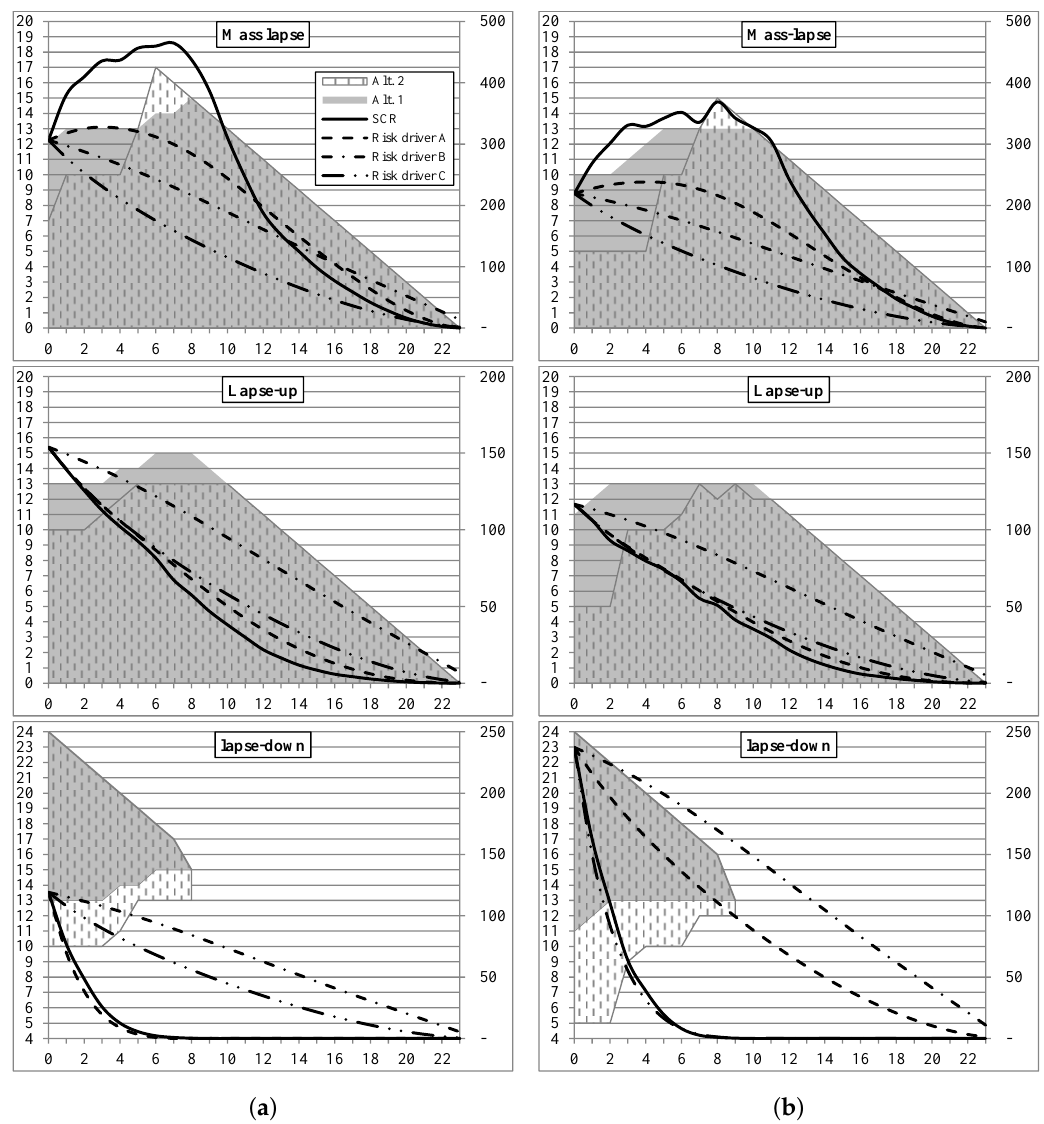
Figure 1. Development of SCR over time (in A C1000). ( a ) Base case; ( b ) Interest rate